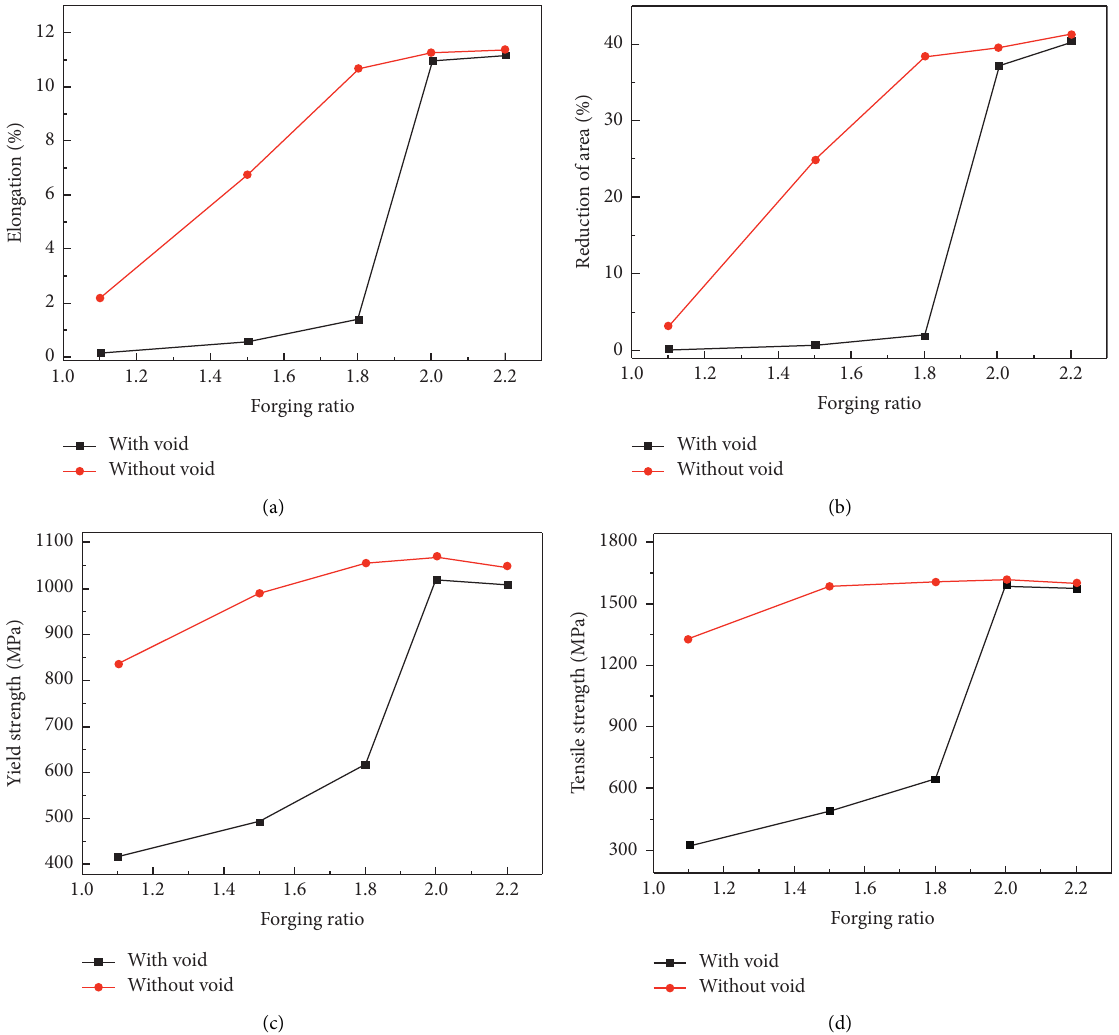
Figure 9: Changes of tensile properties in the crack healing area at different values of FR. (a) Elongation. (b) Reduction of the area. (c) Yield strength. (d) Tensile